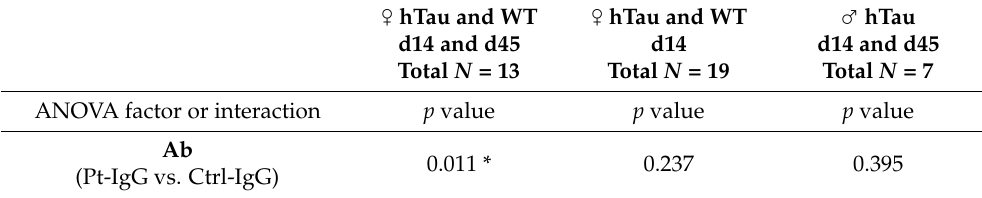
Table A9. Statistical analysis of ventilatory period during